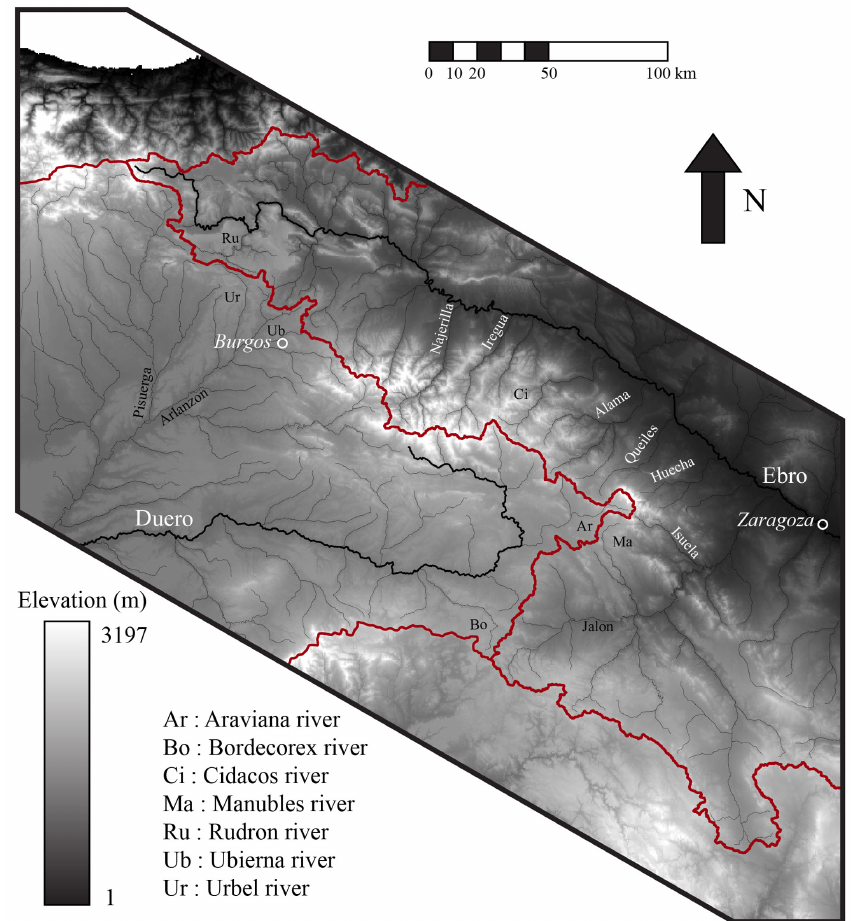
Figure 3. Topographic map of the study area with all the rivers considered in this study. The red lines represent drainage divides between main hydrographic